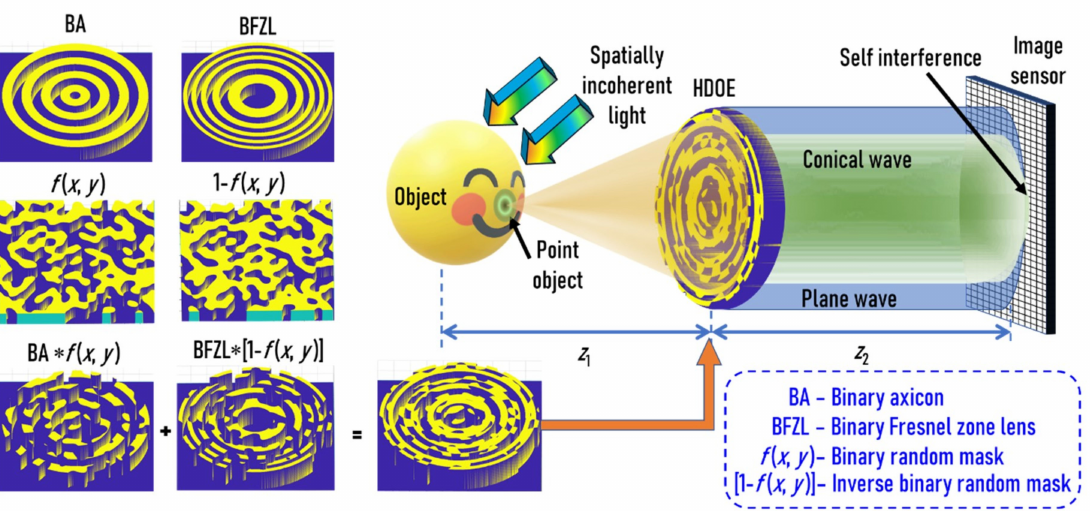
Figure 1. Optical configuration of Fresnel incoherent correlation holography (FINCH) with a randomly multiplexed axicon and a Fresnel zone lens. A conical wave (green) and a plane wave (blue) is generated for every object point. The two beams have the same diameter. The creation of the hybrid di ff ractive optical element (HDOE) from a binary axicon, a binary Fresnel zone lens, binary random matrix, and an inverse binary random matrix is